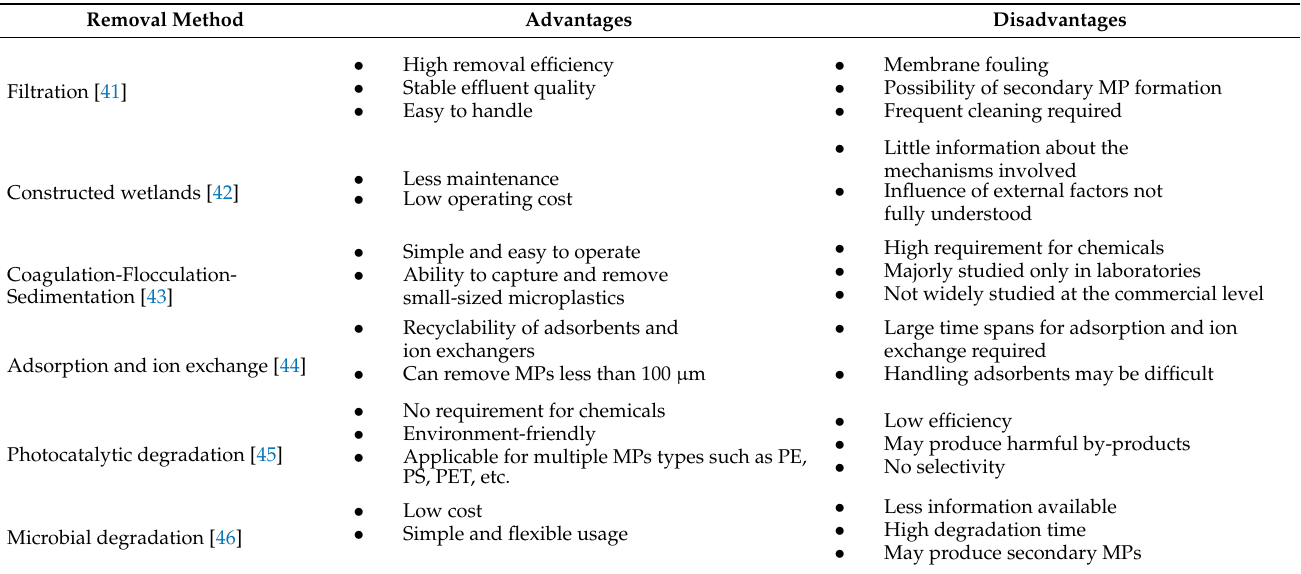
Table 2. Advantages and disadvantages of methods employed for microplastic removal from aqueous media.